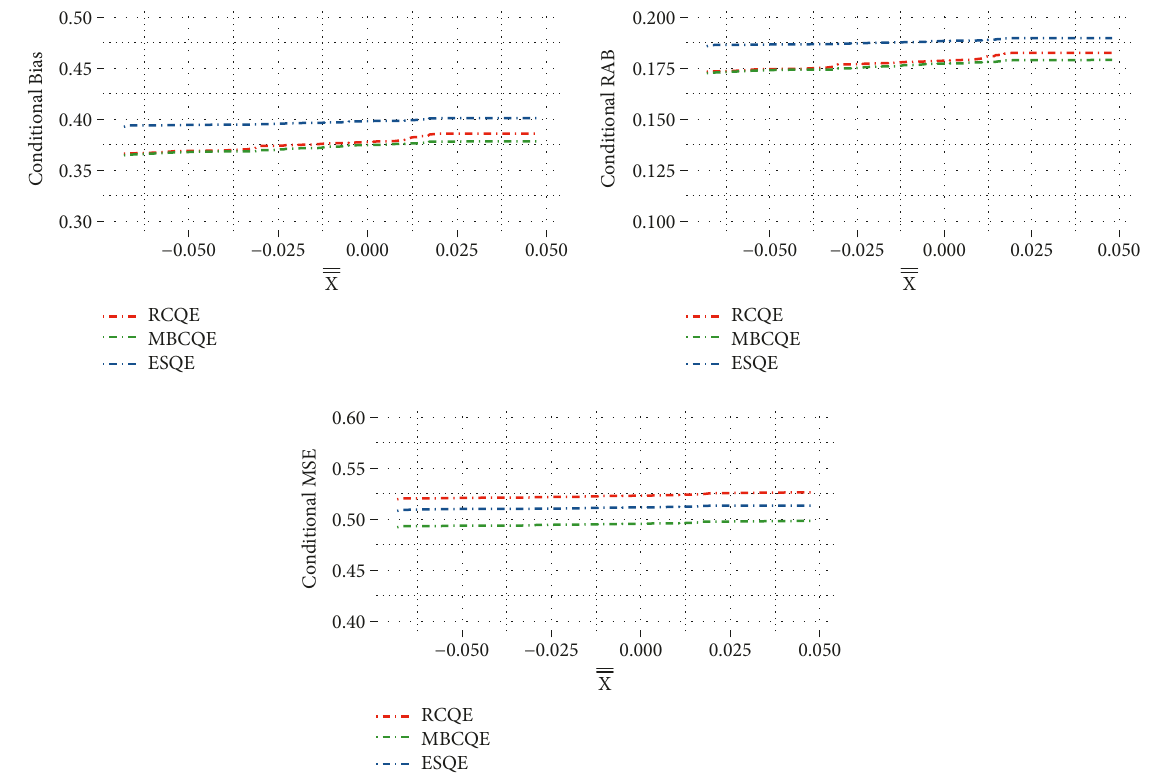
Figure 4: CB, CRAB, and CMSE for estimators: cosine mean function, α � 0 .